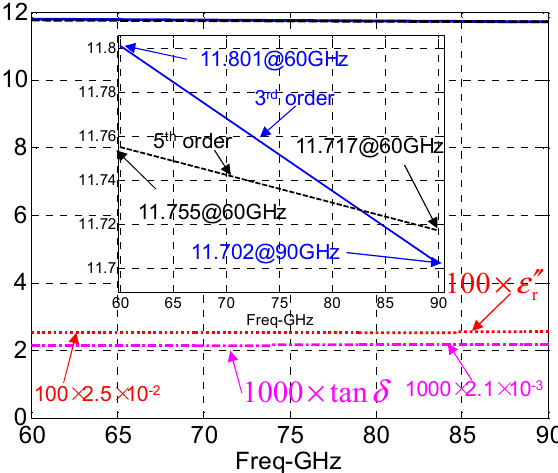
Figure 8. The permittivity in the E-band at 25 °C.